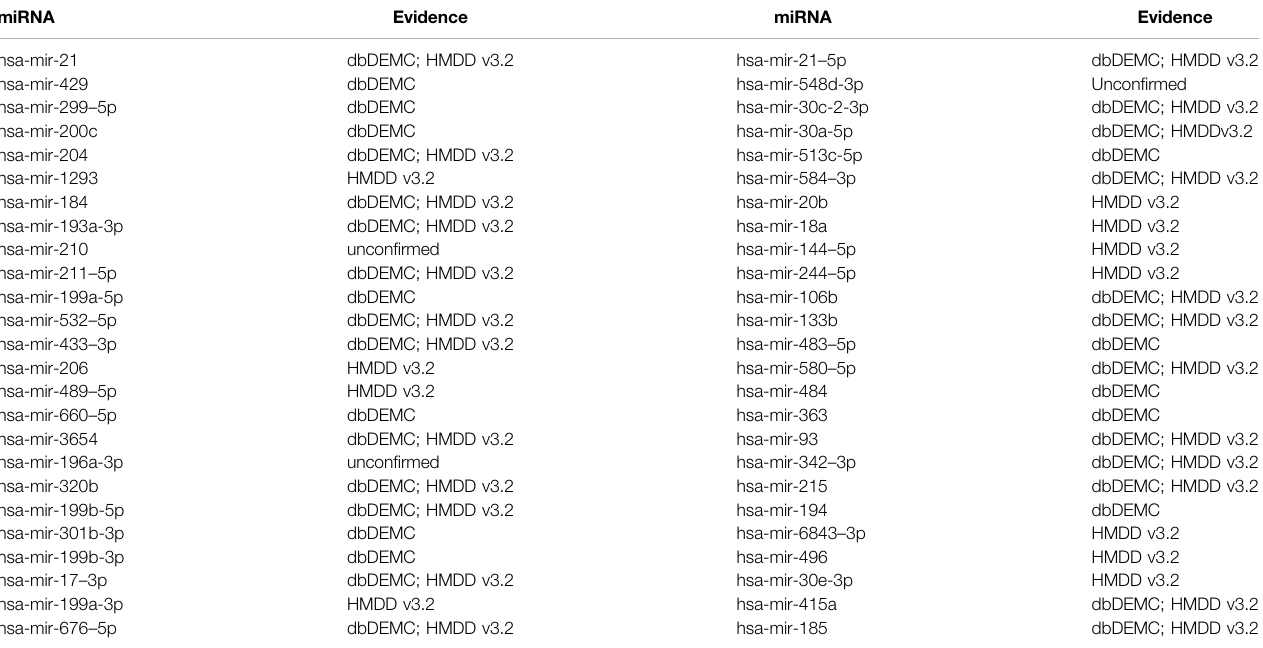
TABLE 3 | Based on the validated associations provided by dbDEMC and HMDD v3.2, the top 50 miRNAs related to kidney neoplasm were predicted by employing BGANMDA model, and 48 predictions were con fi rmed based on dbDEMC and miR2Disease. The fi rst column records the top 1 – 25 predicted potentially relevant miRNAs and the third column records the 26 – 50 predicted potentially related